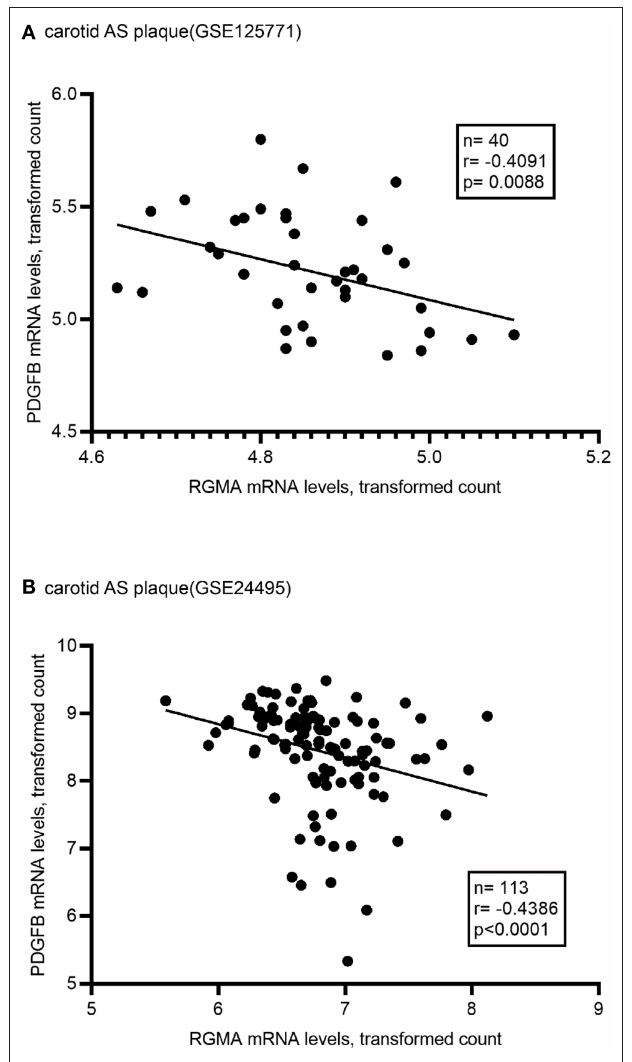
FIGURE 2 | The association of RGMA with PDGFB in human carotid AS plaque. (A,B) In the two independent datasets from GEO database (GSE125771, GSE24495), RGMA mRNA transcription levels in carotid AS plaque negatively correlated with PDGFB mRNA levels. The correlation was tested by Spearman’s rank test ( A : r = − 0.4091, P = 0.0088; B : r = − 0.4386, p < 0.0001). The solid line indicates the linear regression fit of the measured data.